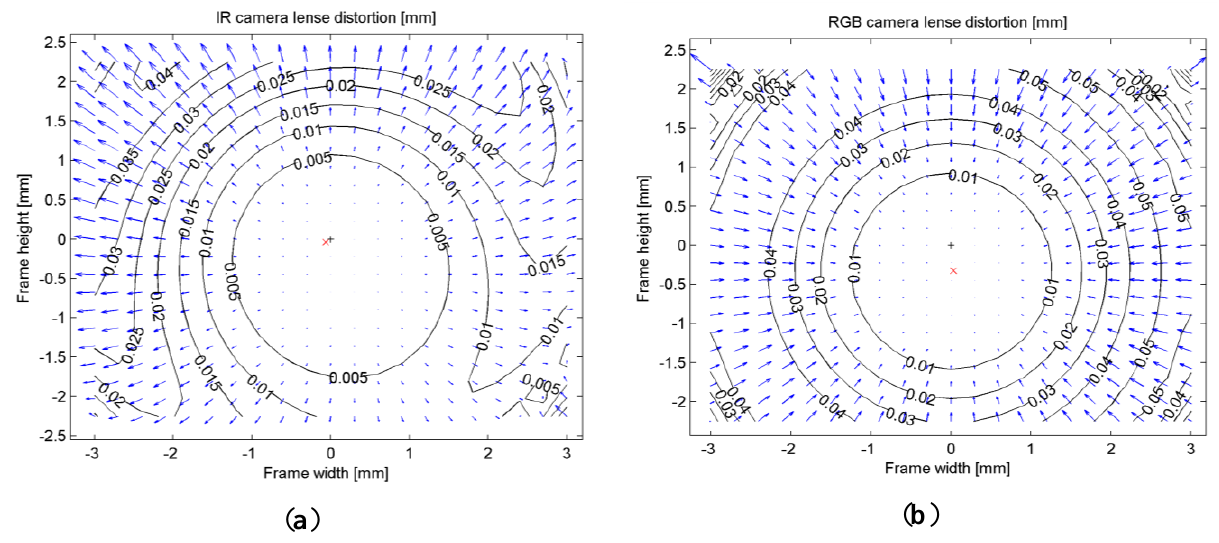
Figure 3. Lens distortions of ( a ) IR camera and ( b ) RGB camera. The principal points are marked by x and the image centers by +.